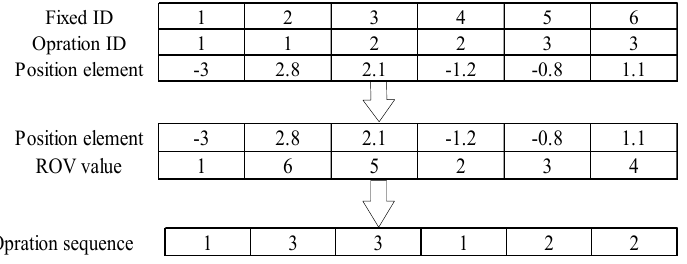
Figure 4. The conversion from individual position vector to operation sequence.